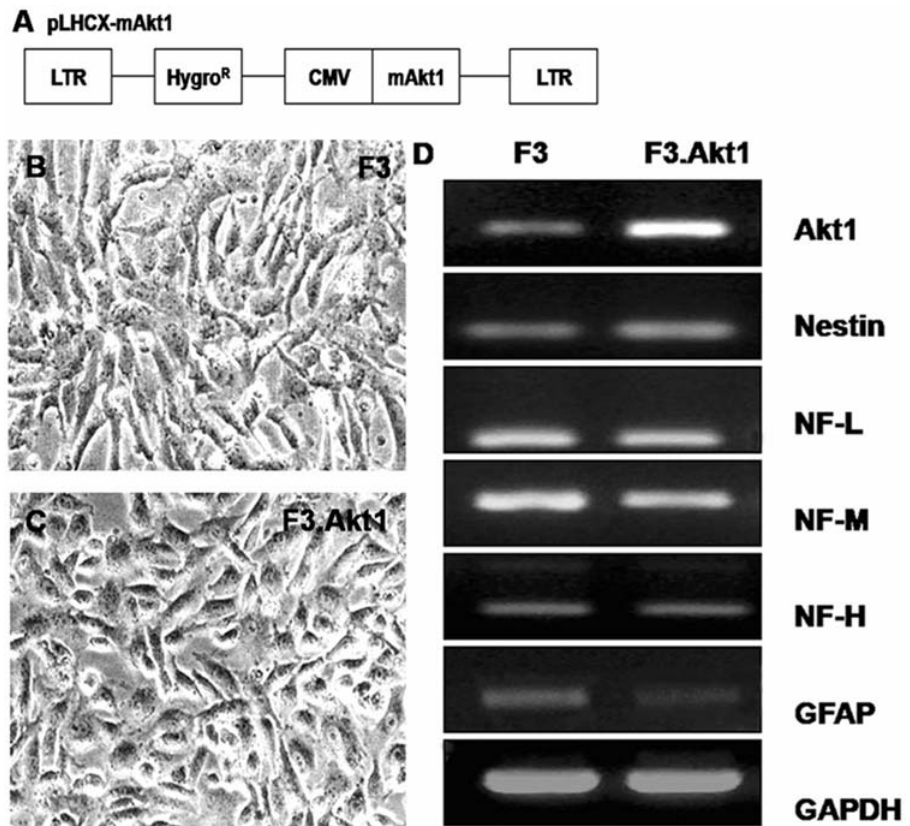
Figure 1. Characterization of human NSC lines. A: The retroviral vector encoding Akt1 (pLHCX.Akt1) used in the present study for the generation of HB1.F3.Akt1 (F3.Akt1) human neural stem cell (NSC) line. B and C: Phase contrast microscopy of F3 and F3.Akt1 human NSCs. Bar inciates 20 m m. D: Gene expression of cell type-specific markers as studied by RT-PCR in F3 and F3.Akt1 human NSCs. Both of F3 and F3.Akt1 NSC lines express cell type-specific markers Nestin (for neural stem cells), NF-L, NF-M and NF-H (for neurons), GFAP (for astrocytes) and Akt1.